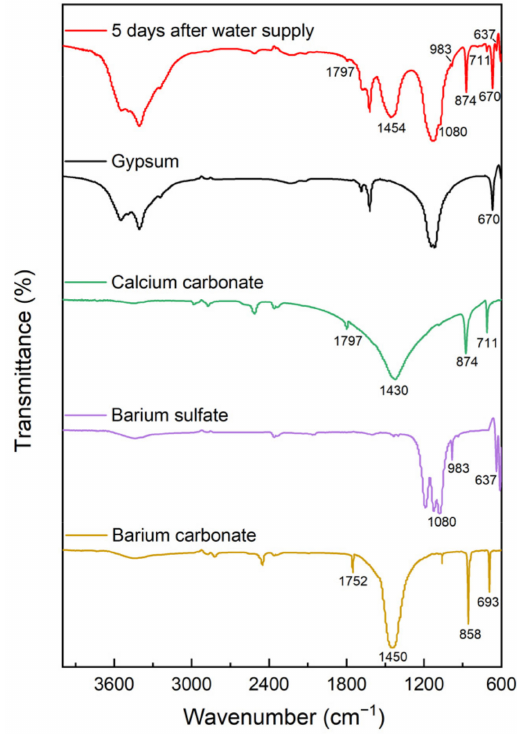
Figure 5. FTIR spectra of the specimen after the water